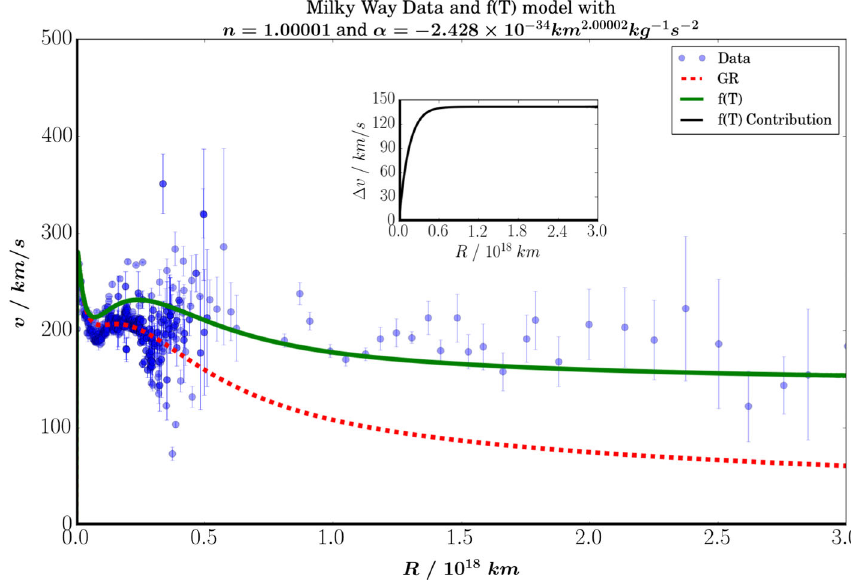
Fig. 3 Best fit model for the rotation profile in f ( T ) gravity for the Milky Way galaxy with n = 1 . 00001 and fit coupling parameter α = − 2 . 428 + 1 . 303 −